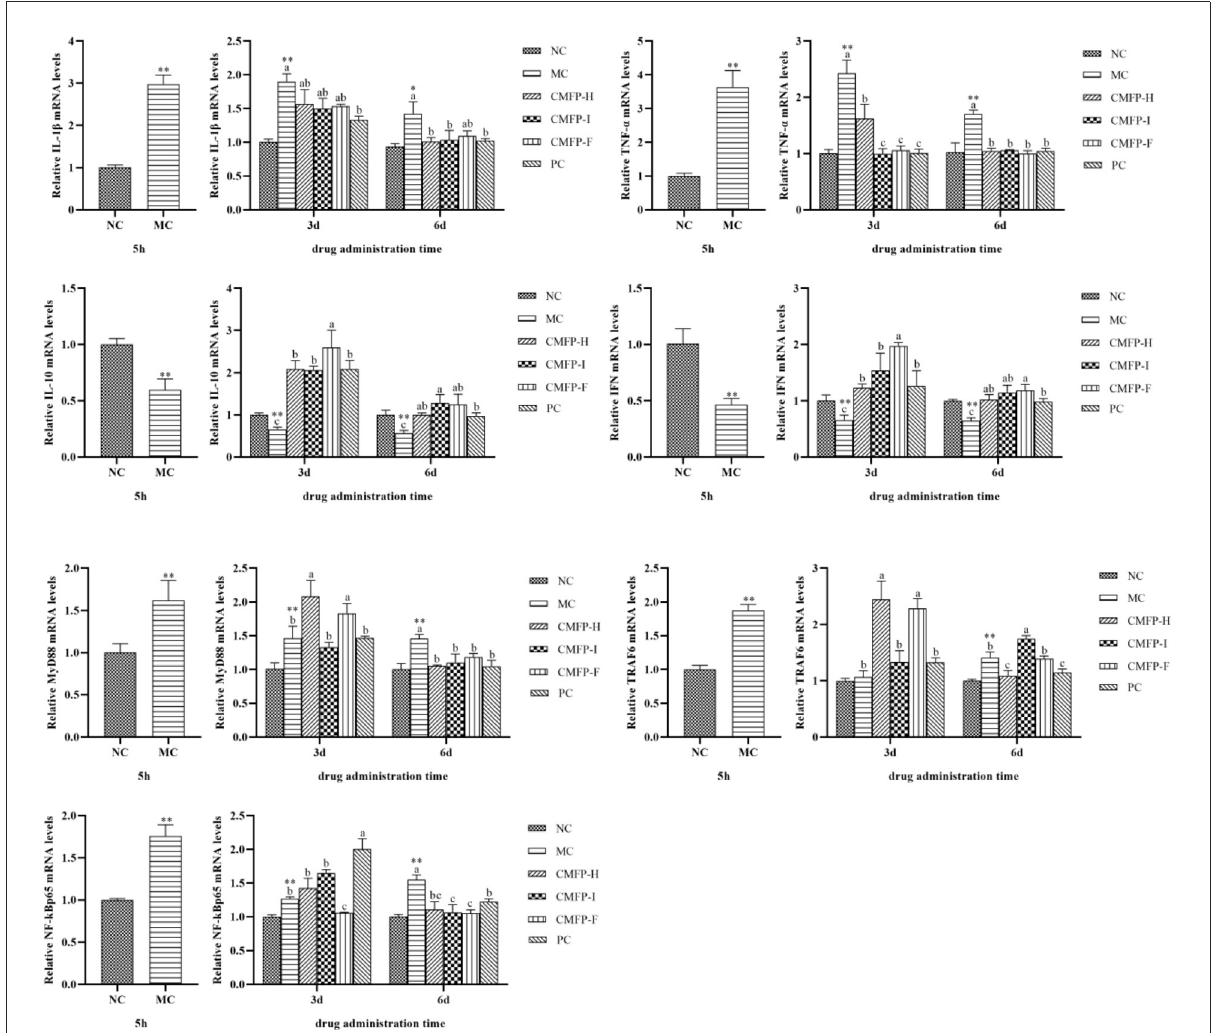
FIGURE5 Effect of CMFPs on the expressions of inflammatory cytokines and MyD88/NF- κ B Signaling Pathways in the intestine of zebrafish with inflammatory bowel disease at 5h, 3 d, and 6 d. MC compared with NC, ** p < 0.01, * p < 0.05; CMFPs and PC groups compared with MC indicated significant differences between groups marked with different letters ( p <